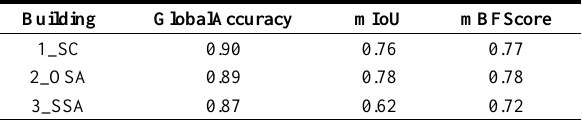
Table 2 . Image semantic segmentation results on the Test Set of the three buildings in the dataset.